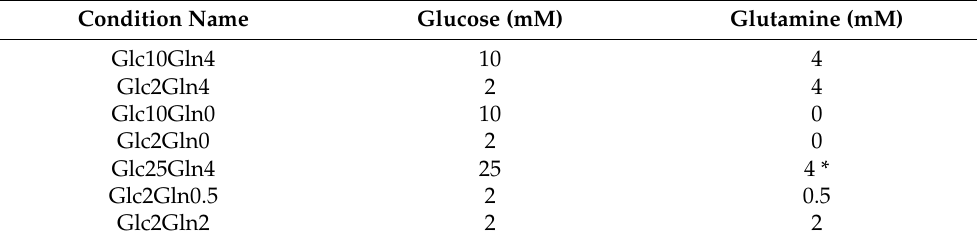
Table 1. The seven different media compositions used to culture U2OS